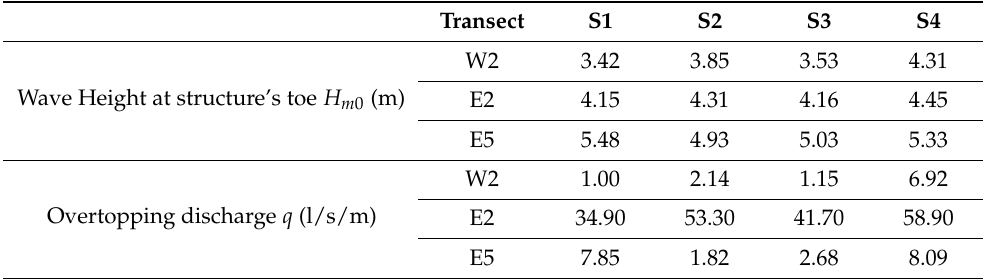
Table 2. Simulated wave heights at the toe of the structures and corresponding mean wave overtop- ping discharges. Transect S1 S2 S3 S4 Wave Height at structure’s toe H m 0 (m)